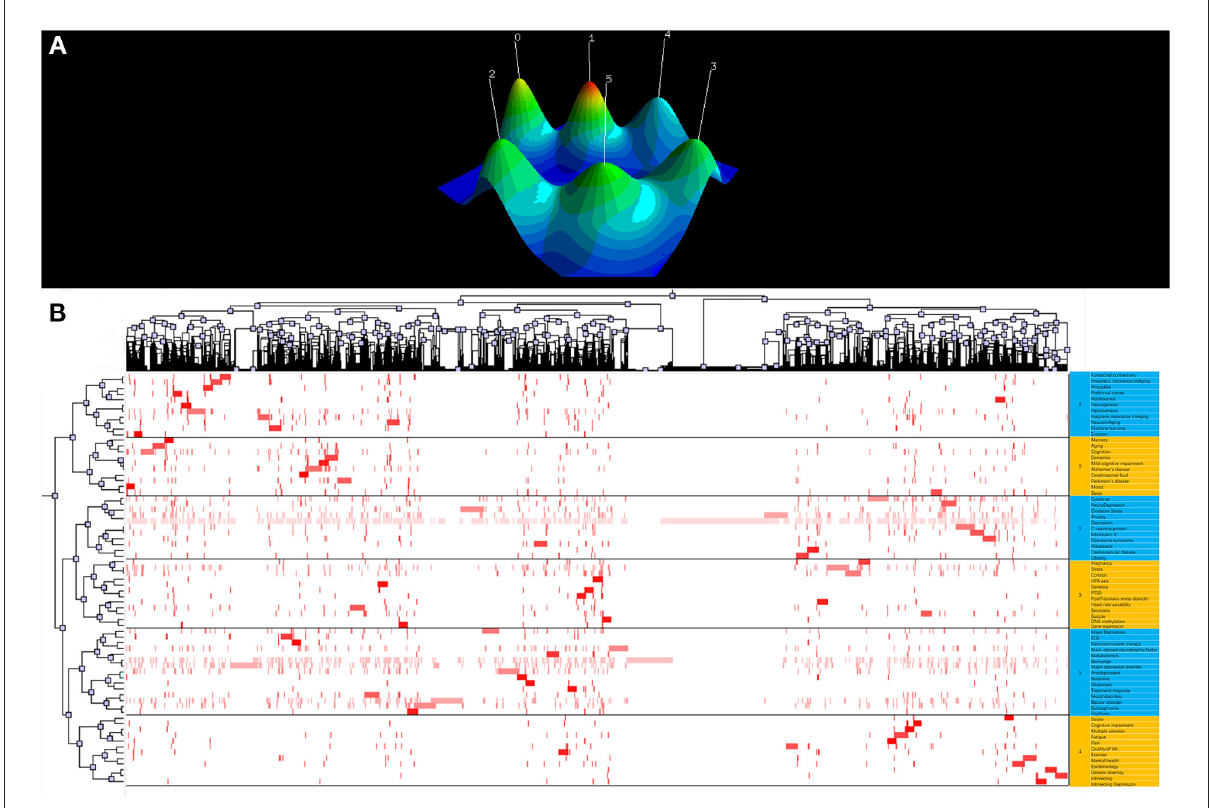
FIGURE5 The visualization of keywords biclustering analysis of depression biomarker research. (A) Visualized Mountain Map based on the Biclustering analysis of depression biomarker Binary Matrix of Word-paper. (B) Visualized matrix based on the biclustering analysis of depression biomarker binary matrix of Word-paper.